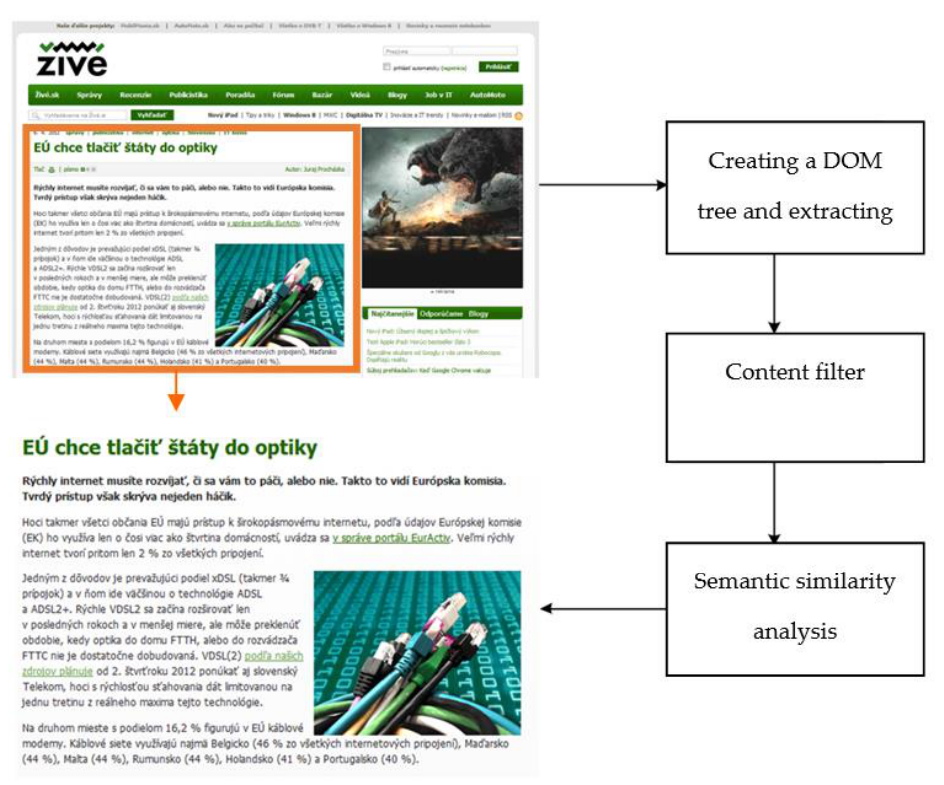
Figure 3. The example of an article extraction from a web document.